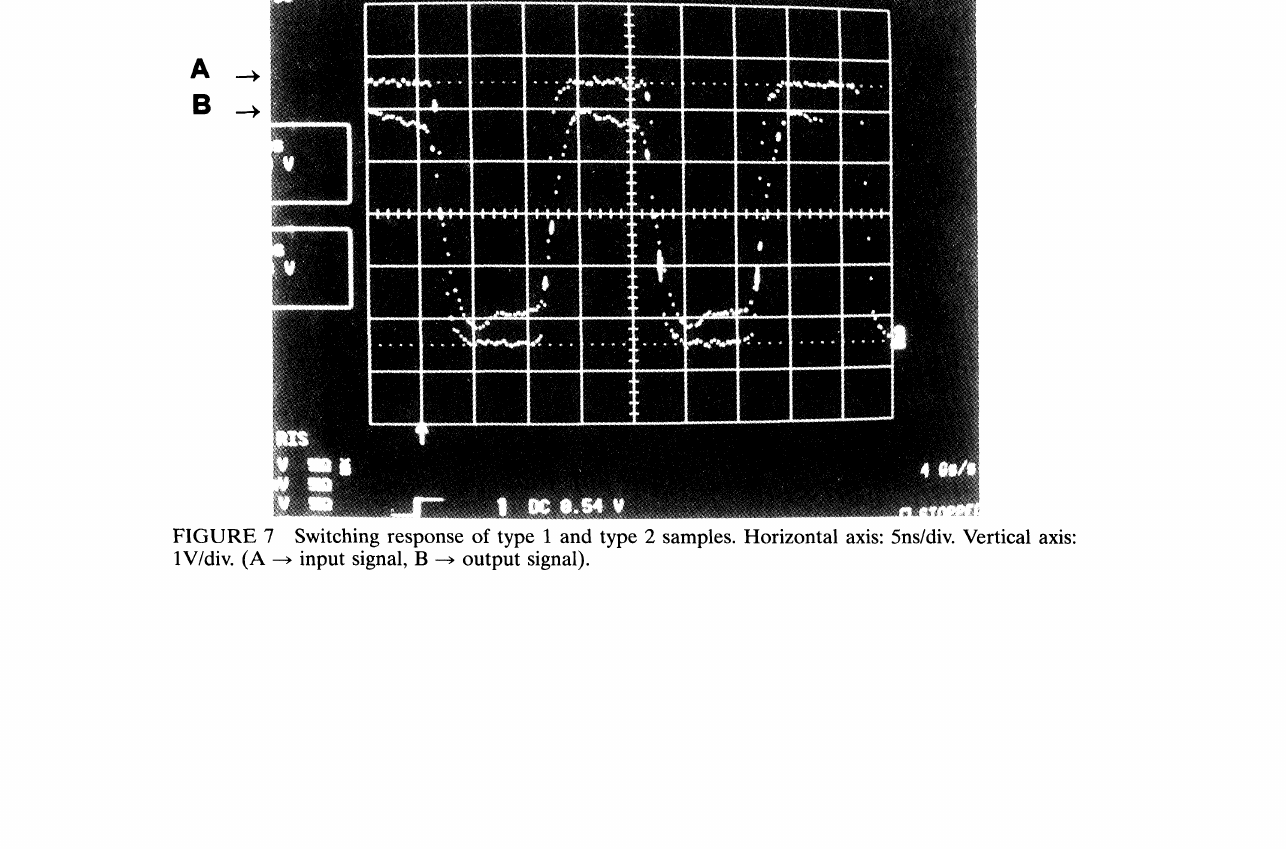
FIGURE 7 Switching response of type and type 2 samples. Horizontal axis: 5ns/div. Vertical axis: 1V/div. (A input signal, B output